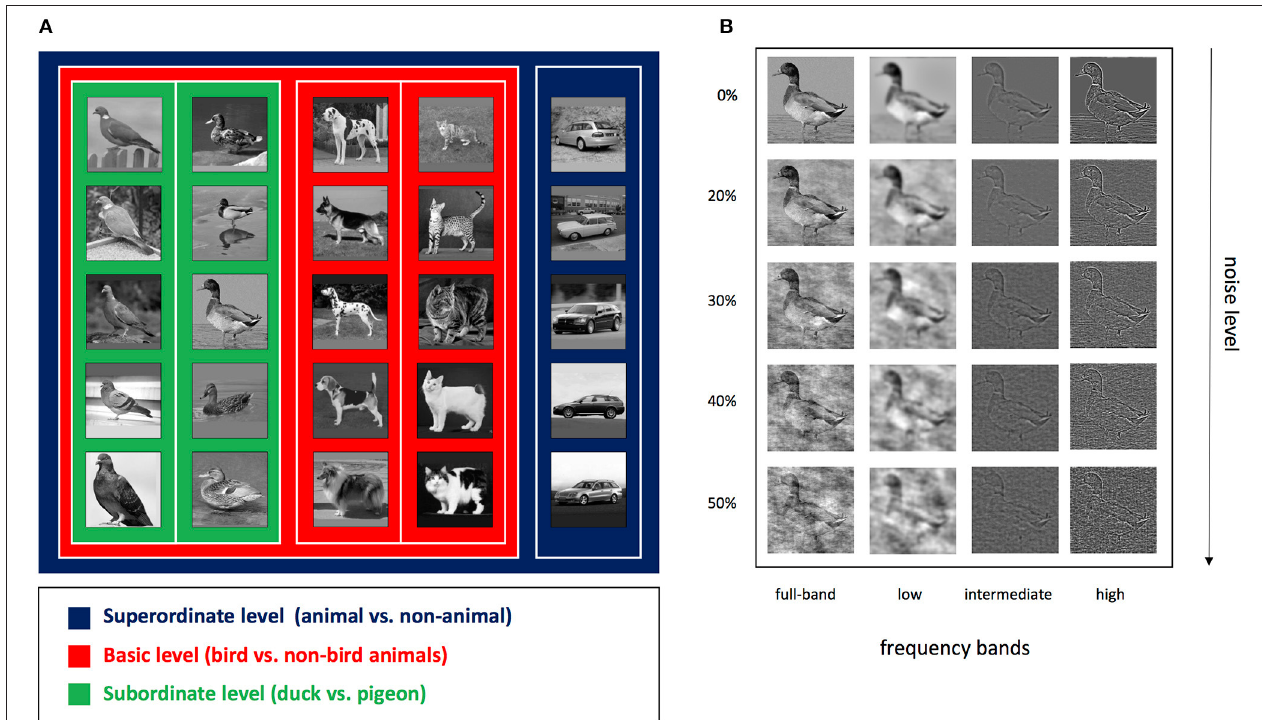
FIGURE 1 | (A) Examples of image stimuli and the hierarchy of three categorization levels. Levels are specified by different colors, i.e., superordinate in blue, basic in red and subordinate in green borders. (B) A sample image bandpass filtered into different spatial frequency bands and contaminated with different amounts of phase noise. Columns specify different frequency bands: full-band (unfiltered image), LSF, ISF, and HSF bands respectively from left to right. Rows correspond to the noise levels: 0% (without noise), 20, 30, 40, and 50% phase noise respectively from top to